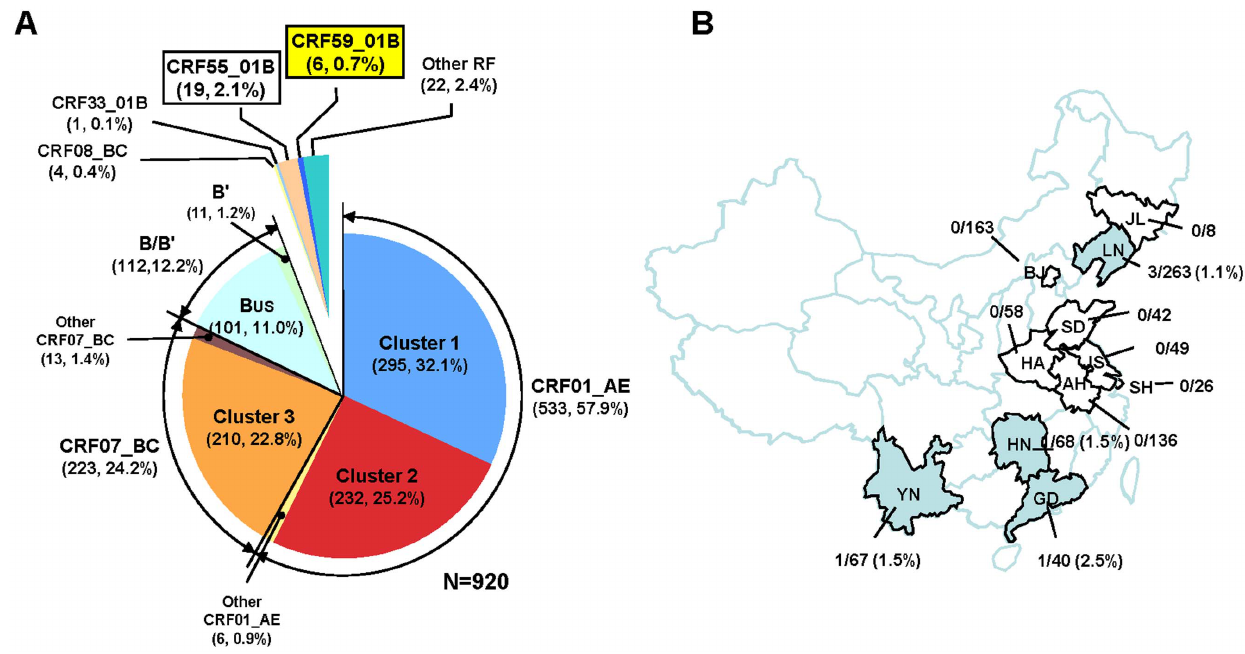
Figure 1. HIV-1 genotype distribution among MSM in China and map of China depicting the occurrence of CRF59_01B. (A) The overall genotype distribution of HIV-1 strains among MSM newly diagnosed during 2008–2013 in 11 provinces in China (n=920). (B) Map of China. Study sites (11 provinces) and the proportion of CRF59_01B among HIV-1 strains in their respective provinces.